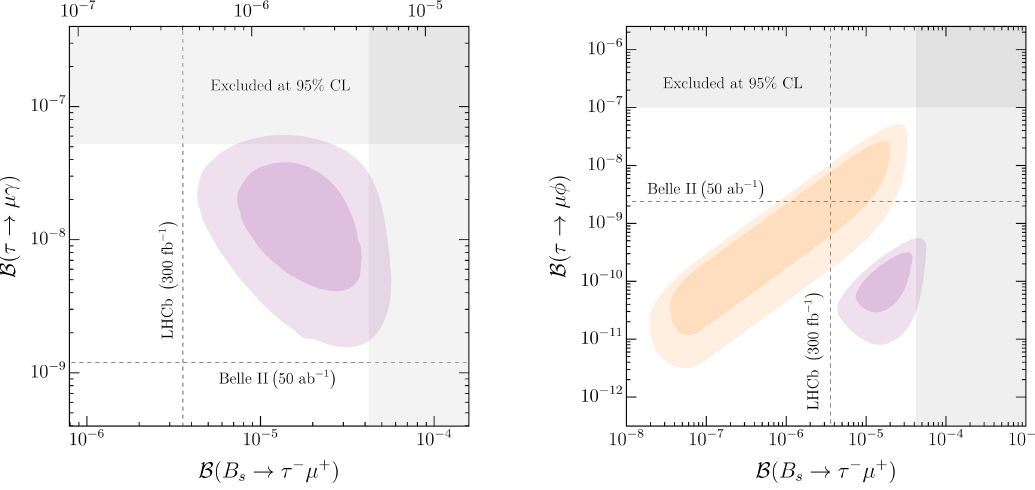
Figure 9 . Preferred 1 σ and 2 σ regions for LFV processes resulting from the low-energy fit in the = 0 (orange) and β bτ = − 1 (purple). The gray bands show the 95% CL U 1 simplified model for β bτ R R experimental exclusion limits. Future projections (rescaled to 95% CL) are denoted by dashed lines. In the x − axis of the left plot only the more stringent exclusion band from B − µ + is s → τ